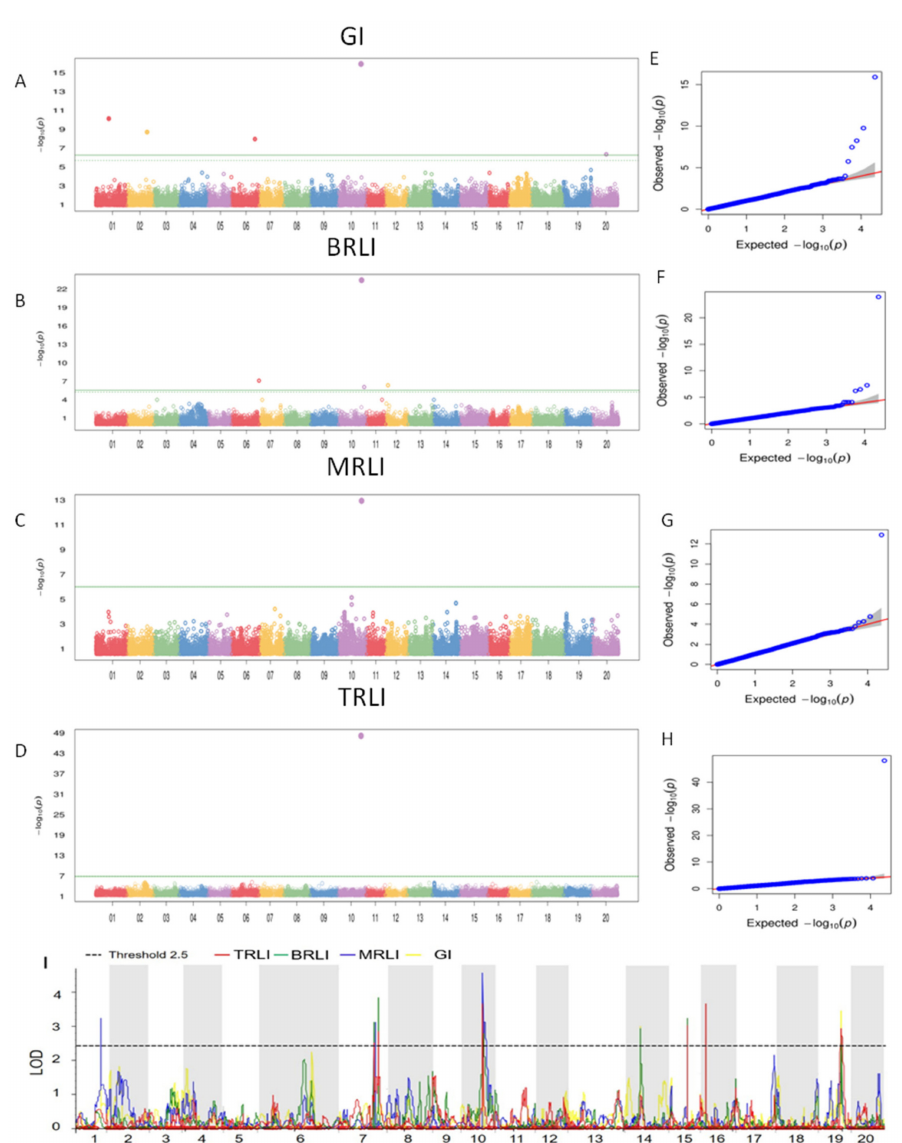
Figure 2. GWAS and QTL mapping of soybean tolerance to drought at the germination stage. ( A – D ) Manhattan plot of the four traits. ( E – H ) QQ plot of the four traits. ( I ) The QTL mapping results of soybean tolerance to drought at the germination